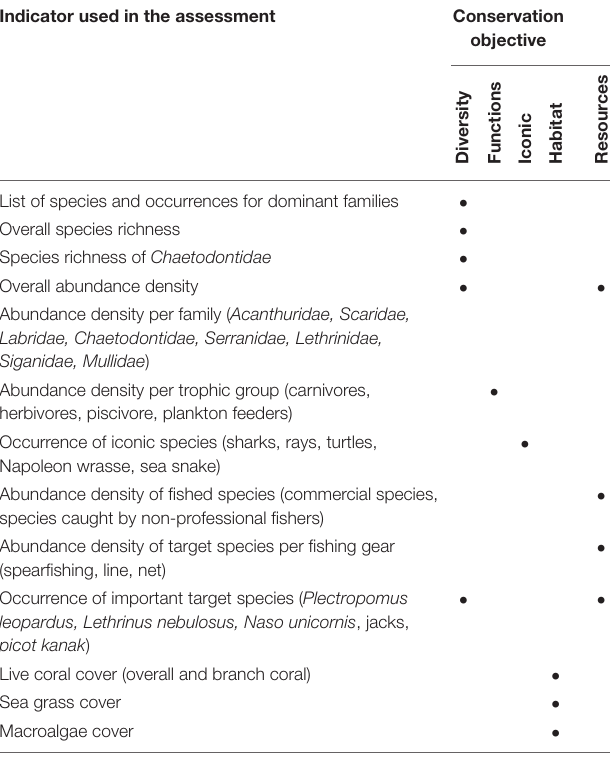
TABLE 7 | Indicators derived from STAVIRO data collected in New Caledonia to document EBV related to mobile macrofauna in the light of tracking progress toward conservation